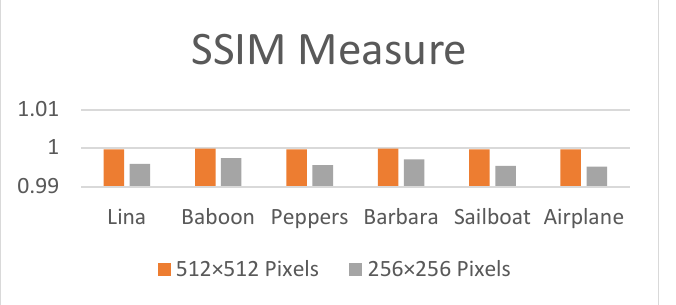
Figure 6. SSIM measure for embedding 2000 bytes in colour images of sizes 512 × 512 and 256 ×